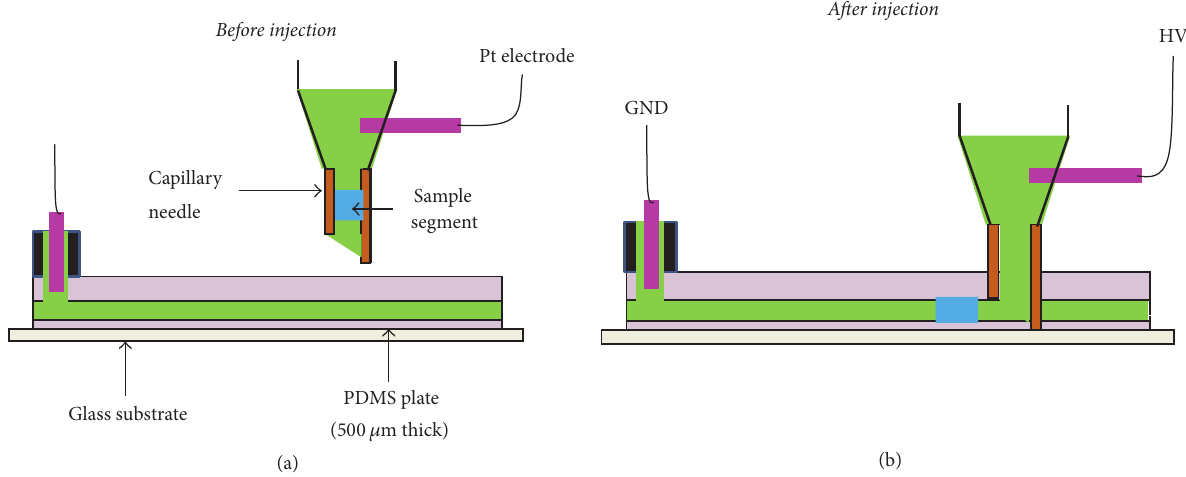
Figure 3: Schematic diagram to show the AICEI technique. (a) Before injection: a homemade capillary needle position is adjusted in the horizontal plane. (b) After injection: a sample segment is injected by applying acupuncture on a channel and applying a high voltage (single potential, 1kV).